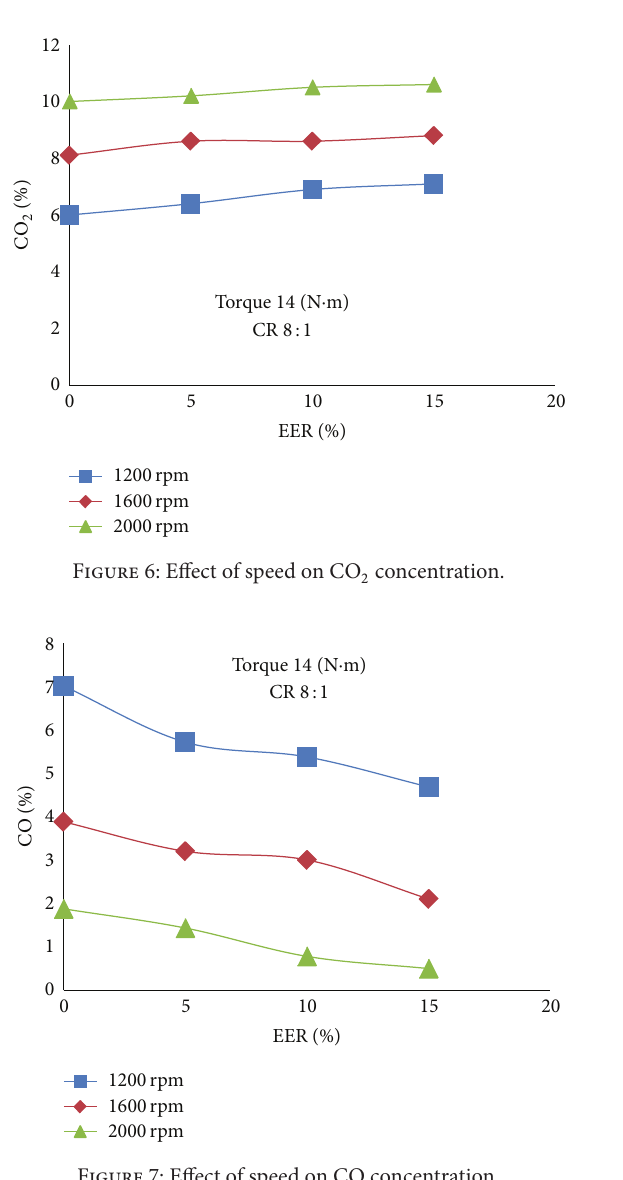
Figure 7: Effect of speed on CO concentration.